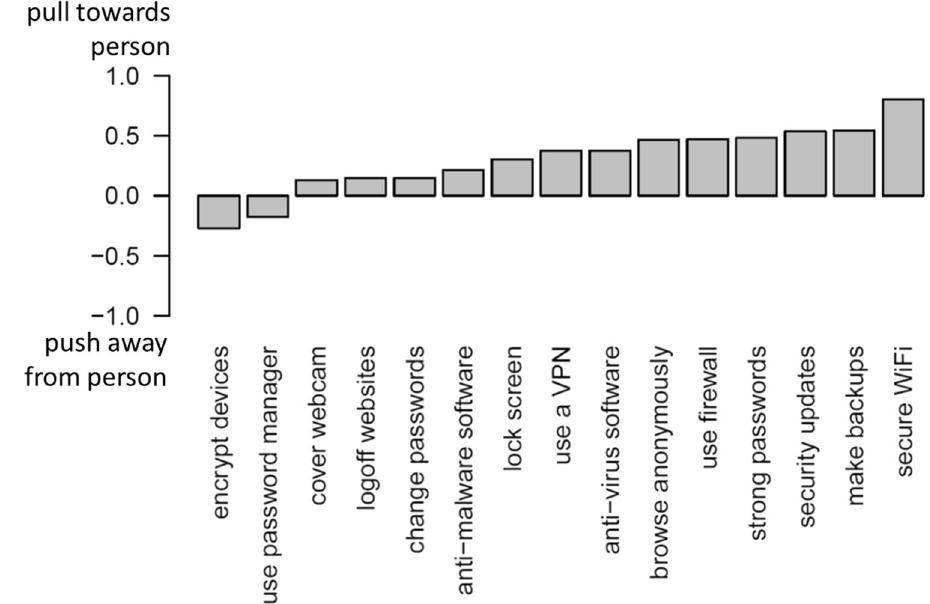
Fig. 11 The barplot depicting movement directions for the displayed cybersecurity-related